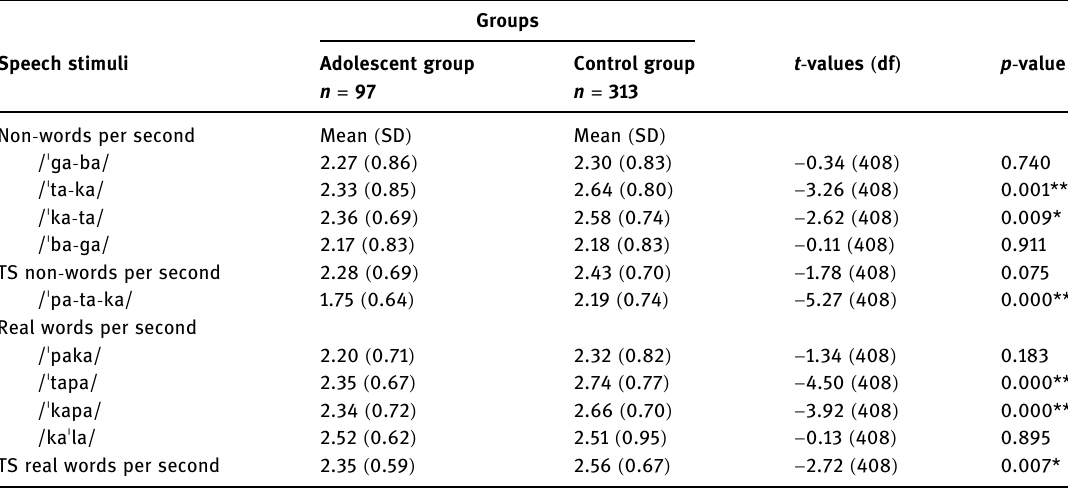
Table 2: Adolescent and control group DDK rates of speech stimuli per second